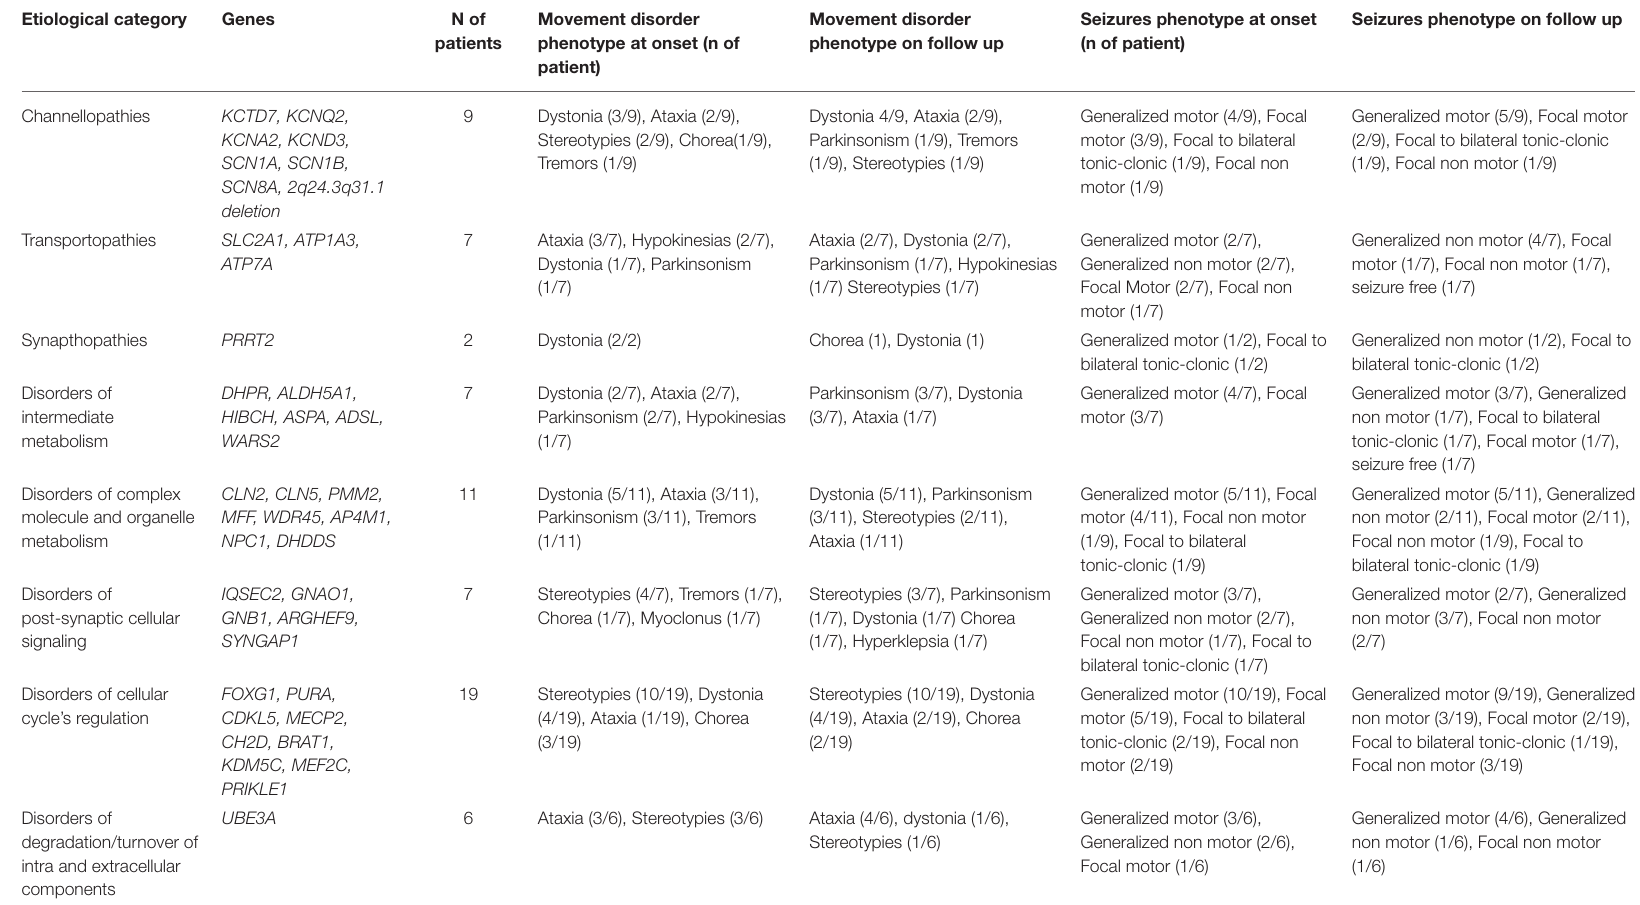
TABLE 4 | Distribution of epilepsy and movement disorder phenotypes at onset and during the follow-up in the different functional groups of genetic etiologies. Etiological